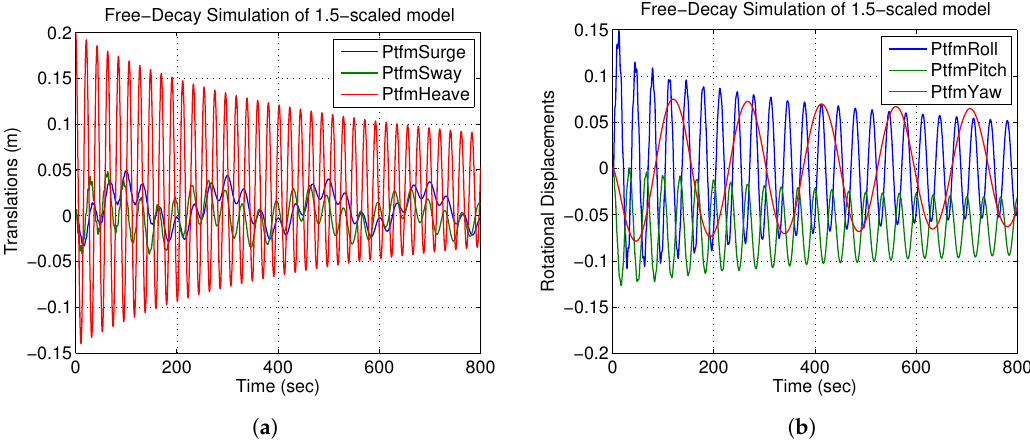
Figure 12. Heave free-decay simulation of the integrated system model following an initial heave displacement of 2 m: ( a ) Modes 1, 2 and 3; ( b ) Modes 4, 5 and